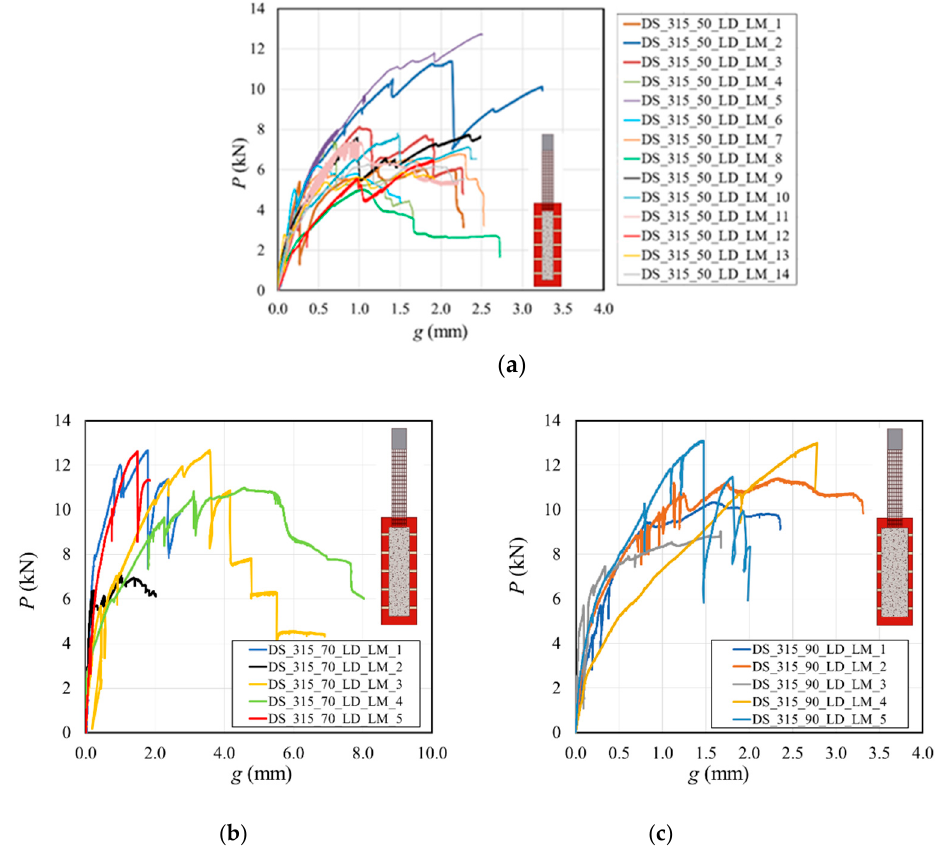
Figure 6. Load responses of SRG-masonry joints with matrix width equal to: ( a ) 50 mm [35]; ( b ) 70 mm; and ( c ) 90